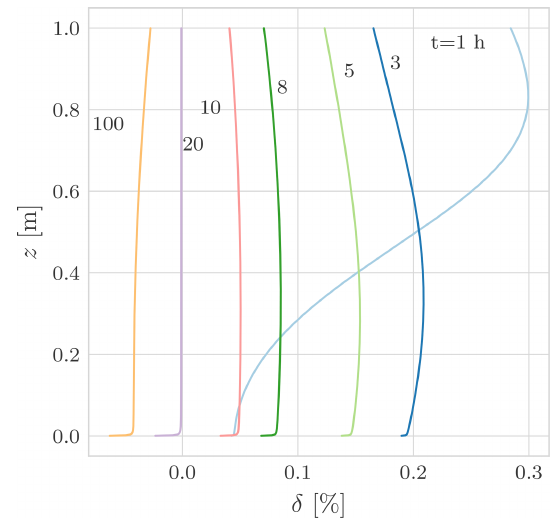
Figure C2. Relative water suction error for the test problem